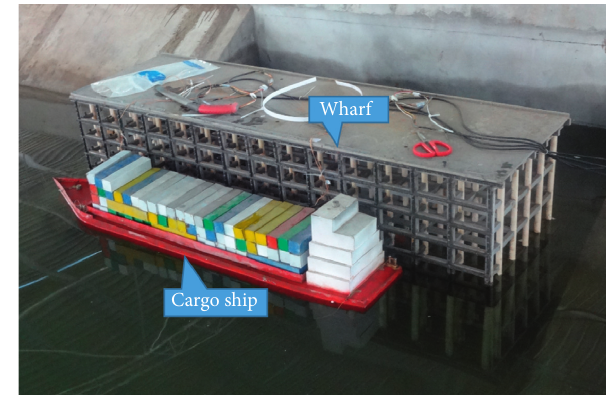
Figure 5: The experimental wharf and moored cargo ship in full- cargo